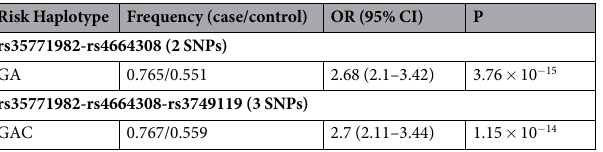
Table 3. Two SNP haplotype analysis of intronic (rs4664308) and missense (rs35771982) (upper table) and three SNP haplotype analysis including the 5 ′ UTR SNP (rs3749119) (lower table). (222 IMN vs. 701 controls). Two-SNP and three-SNP haplotypes are not different because 5 ′ UTR SNP is the almost the same signal as the intronic